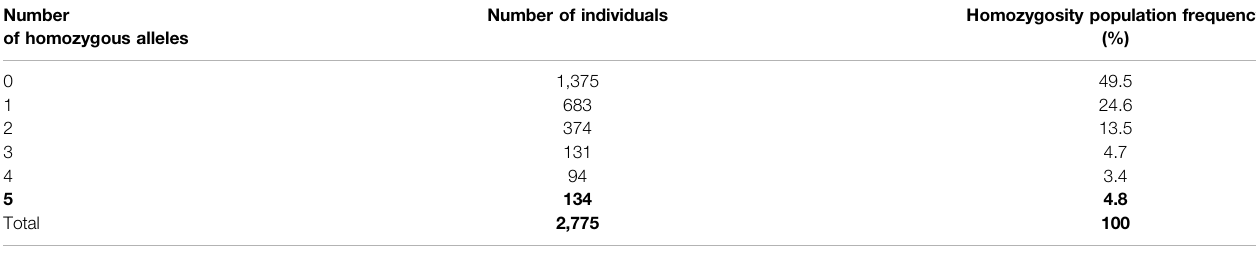
Bold values indicate the highest frequencies.